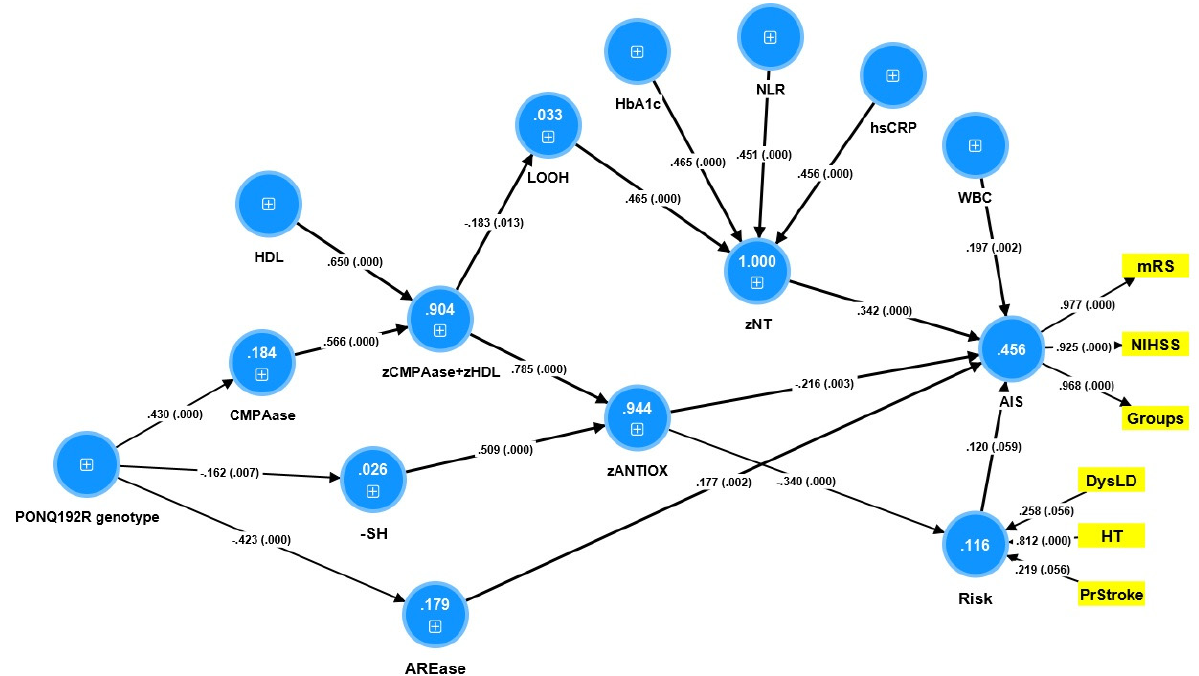
Figure 6. Results of partial least squares (PLS) analysis with severity of acute ischemic stroke (AIS) as final outcome variable. The direct explanatory variables are the neurotoxicity (zNT) index, white blood cell (WBC) count, antioxidant defenses (zANTIOX), classical risk factors (RISK), paraoxonase 1 (PON1) status, including chloromethyl phenylacetate CMPAase and arylesterase (ARE)ase activity and the PON1 Q192 genotype (entered as an additive model coding RR as 2, QR as 1 and QQ 0), high density lipoprotein cholesterol (HDL), and the CMPAase + HDL complex. zNT—composite based on C-reactive protein, neutrophil/lymphocyte ratio (NLR), lipid hydroperoxides (LOOH) and glycated hemoglobin (HbA1c). zANTIOX—a composte based on HDL, CMPAse and sulfhydryl (-SH) groups. AIS was conceptualized as a reflective model with the modified Rankin score (mRS) and National Institutes of Health Stroke Scale (NIHSS) scores as well as an ordinal variable based on the diagnostic groups shown in Table 1 as manifestations. DysLD—dyslipidemia, HT—hypertension, PrStroke—prior stroke.